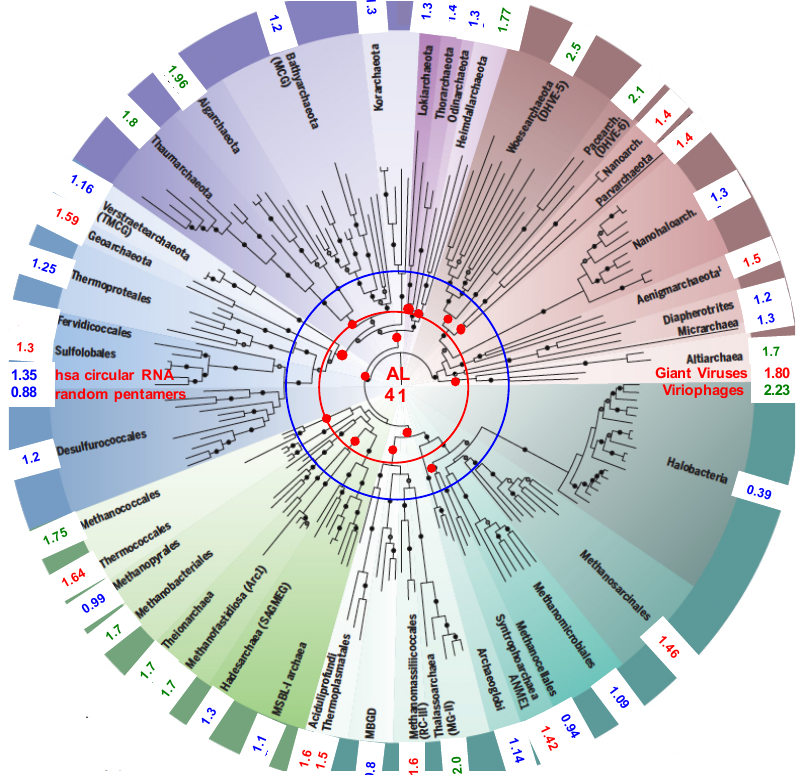
Figure 3. Archaea classification tree. The numbers at the periphery of the circular tree (from [55,56]) indicate the ALPHA pentamer-proximity P 9 of the Archaea genomes to the subset of nine pentamers from ALPHA: {ATTCA, TTCAA, TCAAG, CAAGA, AAGAT, AGATG, GATGA, ATGAA, TGAAT}.